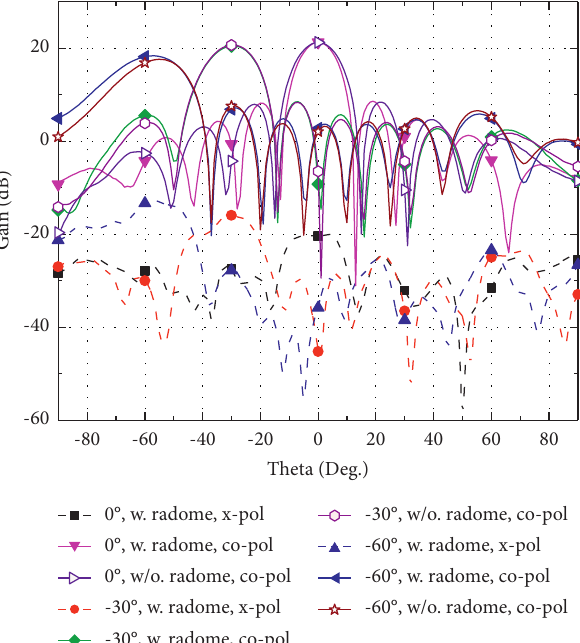
Figure 12: The synthesized results of beam scanning ( H -plane) at 3